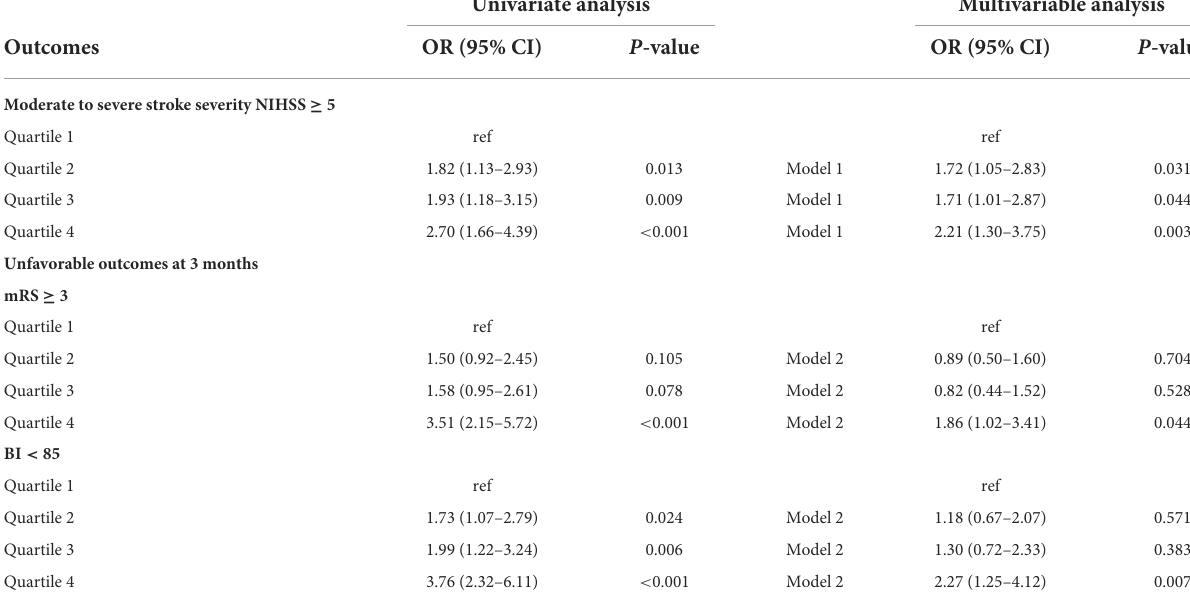
TABLE 3 Risks of stroke severity and functional outcomes according to quartiles of RDW. Univariate analysis Multivariable analysis OR (95% CI) P -value OR (95% CI) P